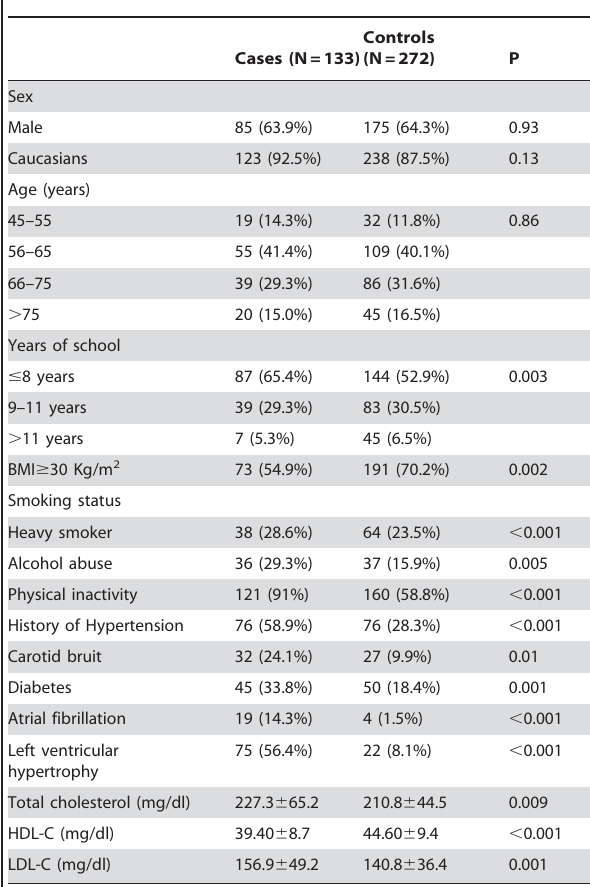
Table 1. Characteristics of case and control